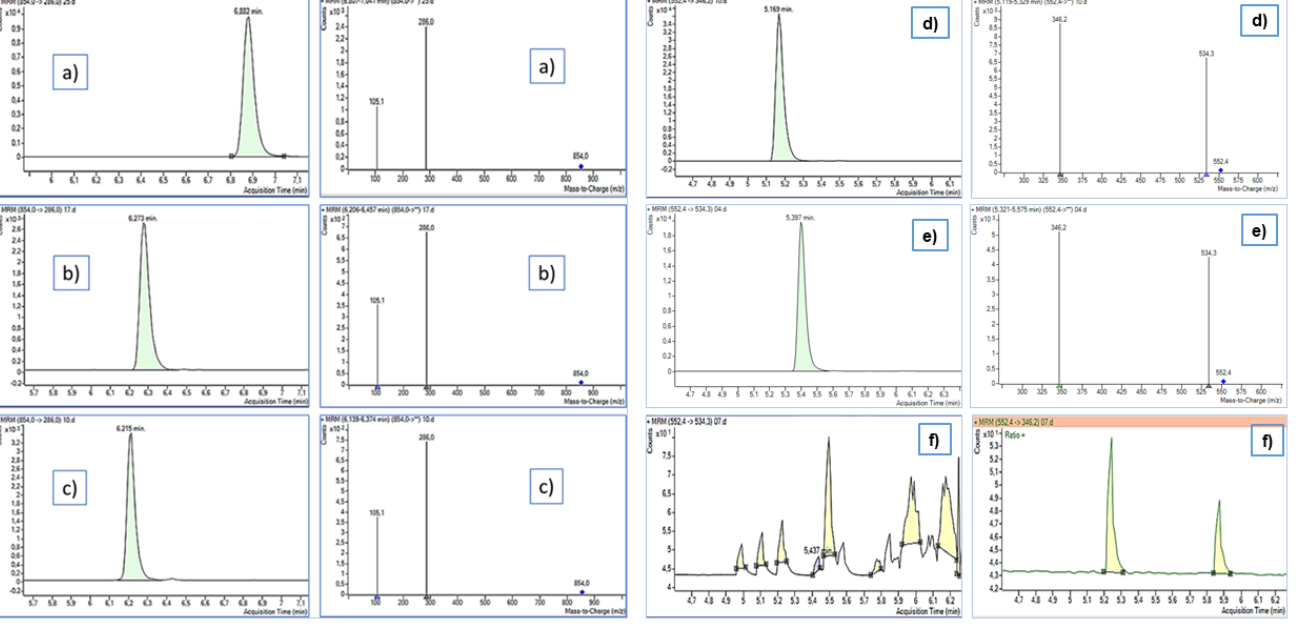
Figure 2. Retention differences for paclitaxel and aliskiren by the three analytical columns. PTX by Kinetex ( a ), Eclipse ( b ), and Luna Omega ( c ); ALK by Kinetex ( d ), Eclipse ( e ), and Luna Omega ( f ).